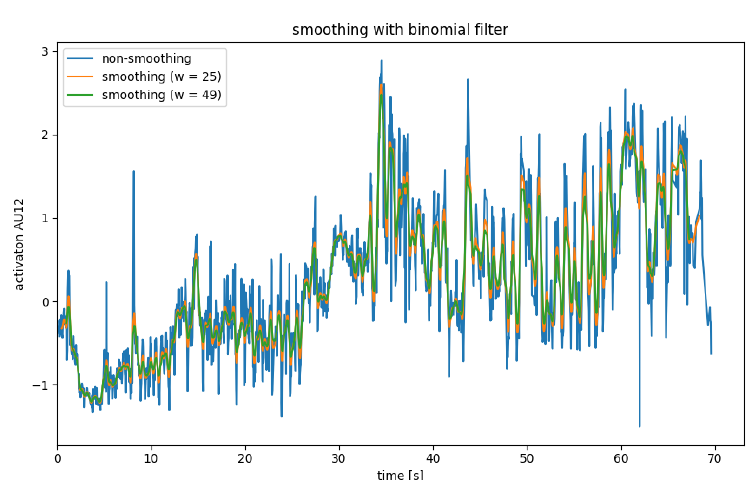
Figure 4. AU smoothing with average mean filter.